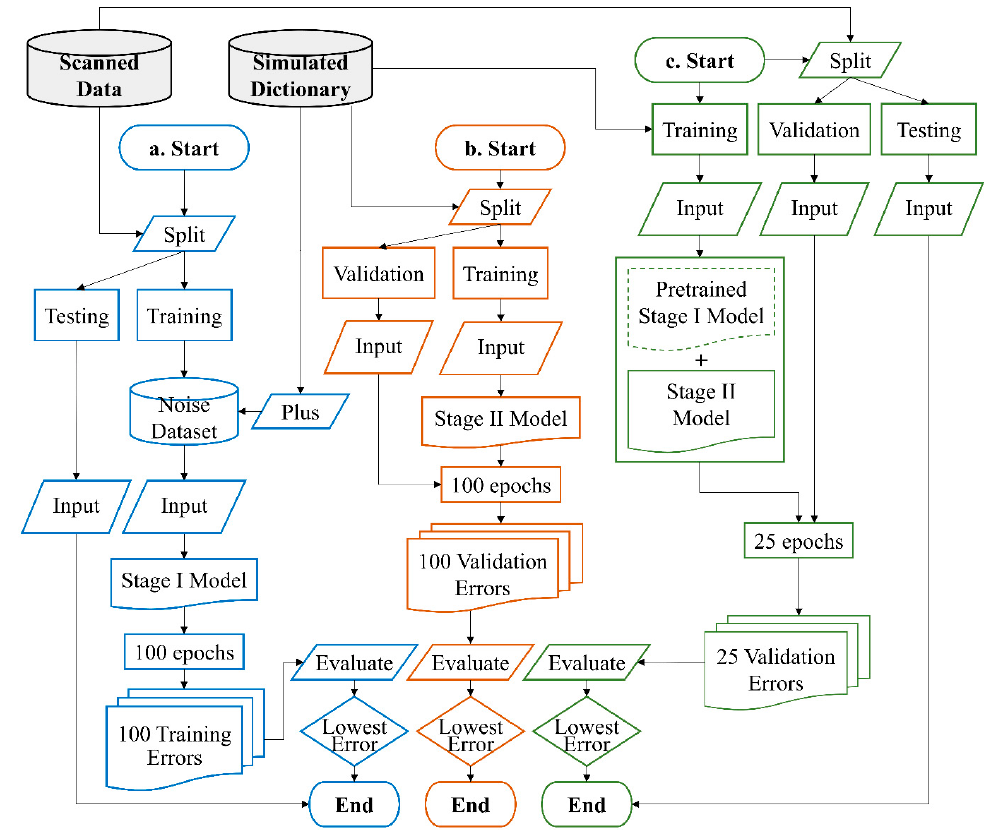
Figure 3. Schematic flowchart for our experiments. ( a ) Workflow for training the denoising models. ( b ) Workflow for training the pyramid models for comparison. ( c ) Workflow for training the final two-stage models. The dashed line for the pretrained stage I model indicates that the model weights were frozen and did not change during the training process.